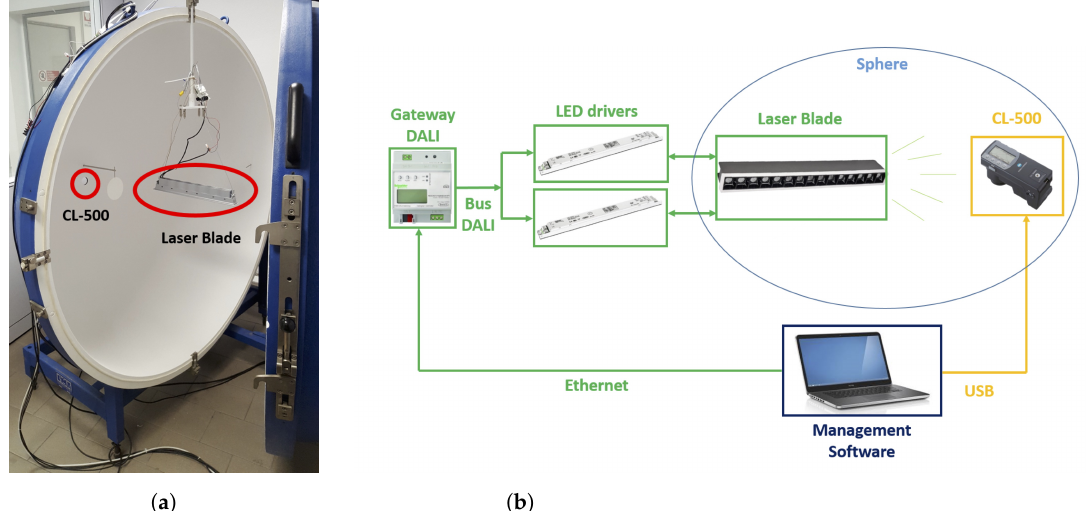
Figure 5. The measurement setup: ( a ) the recommended sphere geometries by the standard for total luminous measurement of the product; ( b ) the architecture